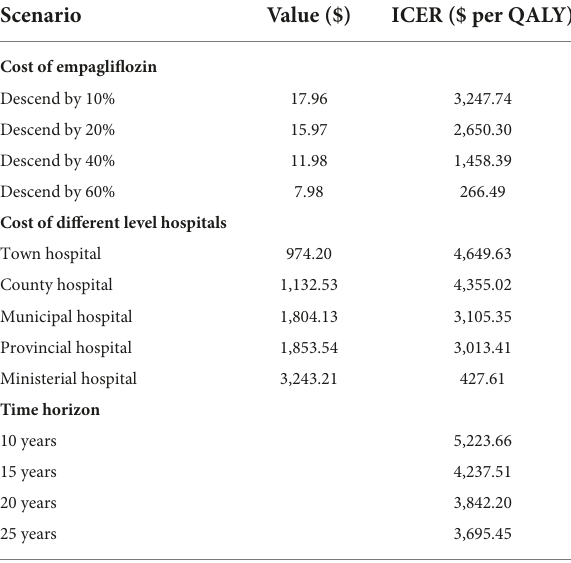
TABLE 3 The results by scenario analyses presented as the ICER.